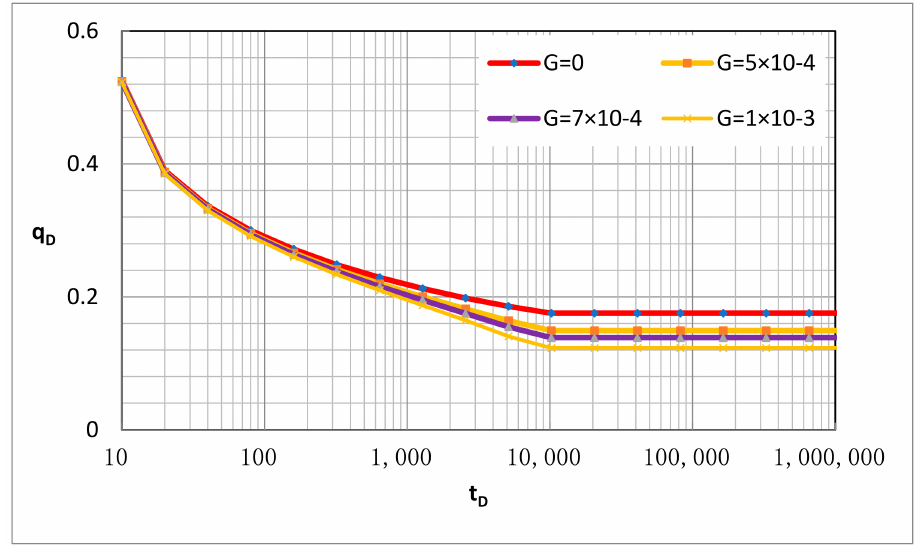
Figure 11. Production decline curve of stable boundary low-permeability reservoir with different starting pressure gradients.